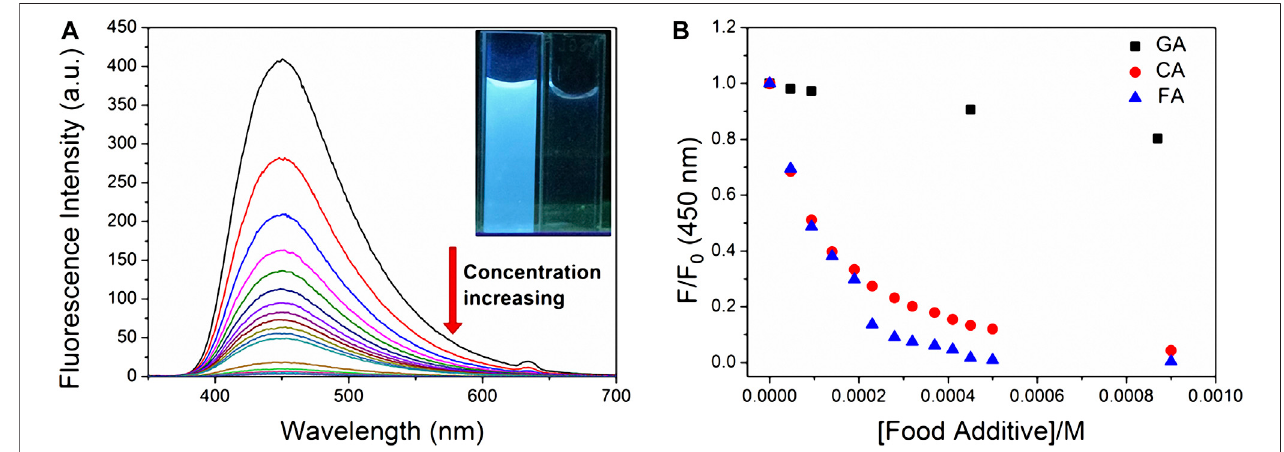
(cid:129) (cid:129) FIGURE 3 | Displacement of the fl uorescent indicator CP6 TNS by various food additives in PBS (pH 6.8). (A) Fluorescence spectra of CP6 TNS (20 µM TNS , 48 µM CP6 , λ ex = 318 nm) upon addition of CA (0 – 2.3 mM). The inset reveals fl uorescence quenching in water at excitation of 365 nm under the UV lamp at 298 K. (B) (cid:129) TNS (20 µM TNS , 48 µM CP6 , λ ex = 318 nm) upon addition of CA , FA , and GA in different Fluorescence intensity changes at 450 nm of CP6 plots increase linearly as the CA , FA , and GA concentrations increase ( Supplementary Figure S8 ), respectively. 0.047 – 2.3 mM, 0.047 – 0.14 mM, and 0.047 – 2.5 mM were the linear ranges. The results indicate that the limit of detection